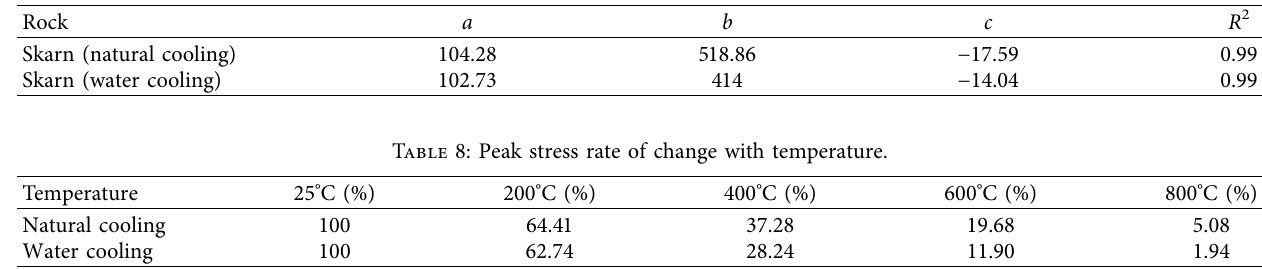
Figure 9: Relationship between elastic modulus and temperature (natural cooling and water cooling). (a) Natural cooling; (b) water cooling; (c) effect of cooling mode on elastic modulus. Table 7: Fitting formula parameter table (natural cooling and water cooling).